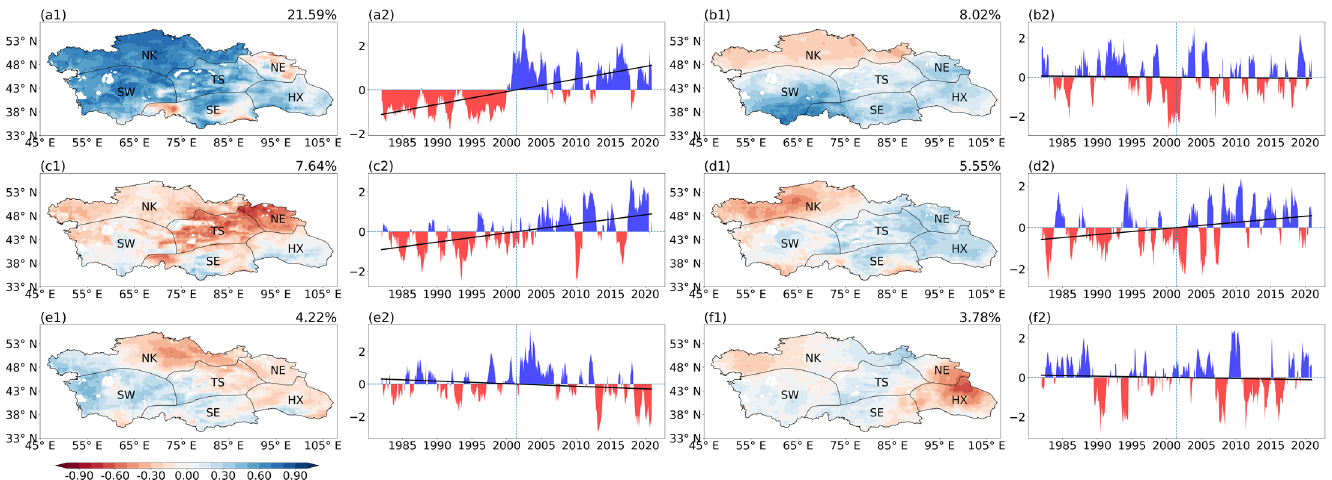
Figure 4. The first six components of the EOF variation based on SPEI12. Subplots ( a1 – f1 ) represent the six component results of EOF, ( a2 – f2 ) represent the time coefficients.